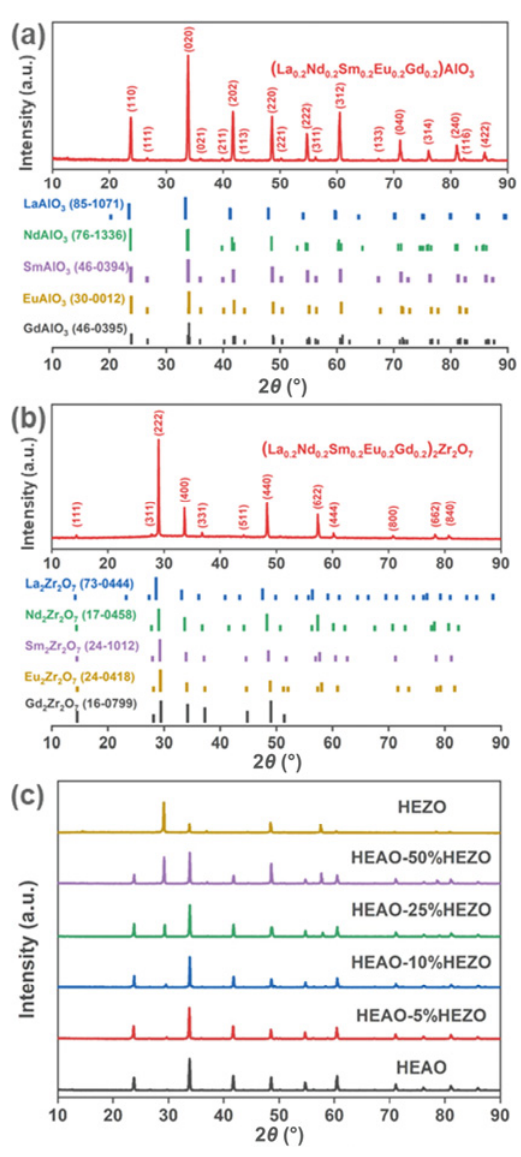
Fig. 1 XRD patterns of (a) synthesized HEAO powders, (b) synthesized HEZO powders, and (c) as-sintered HEAO– x HEZO ceramic